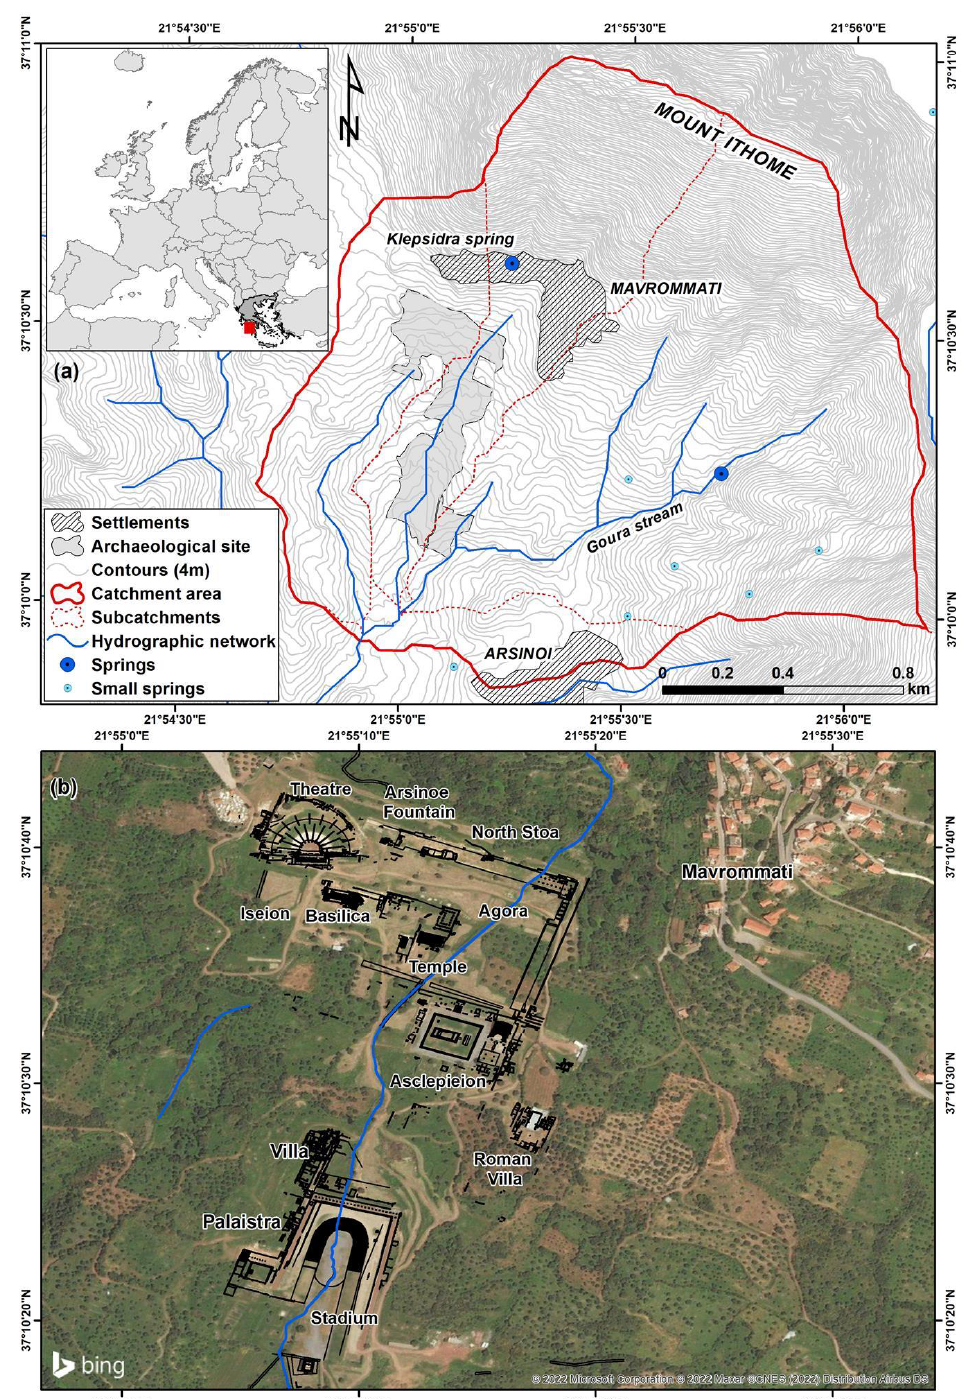
Figure 1. Catchment area ( a ) and detailed plan ( b ) of the Ancient Messene archeological site. The catchment area of Ancient Messene is 3.2 km 2 . The average altitude of the catch- ment is 420 m, and the average slope is 35%. The main anthropogenic activities are agricultural (50% of the area), while 5% is covered by artificial surfaces (discontinuous urban fabric and road network), and 40% is covered by forest. The archaeological site